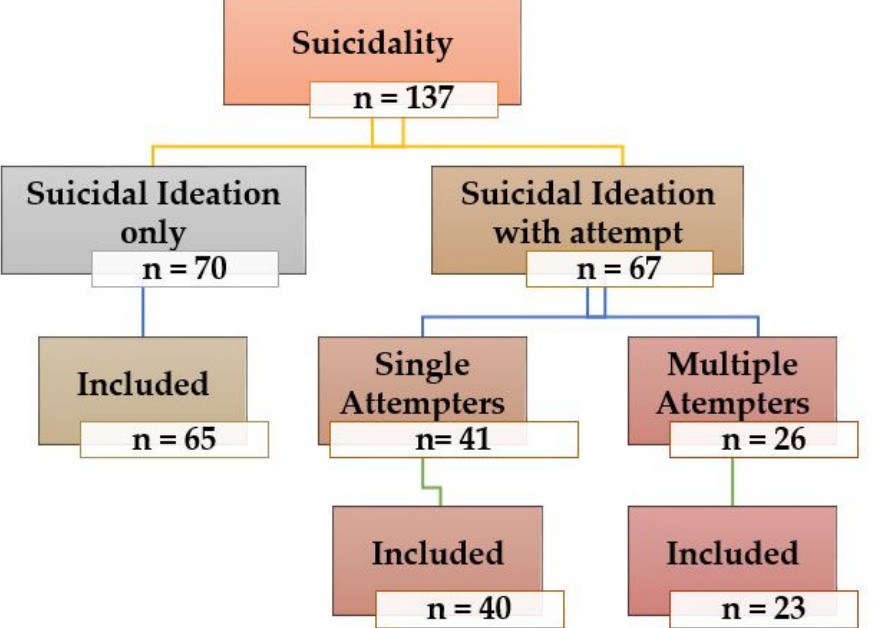
Figure 1. Number and sub classification categories of participants approached for recruitment and included as a study sample for assessment regarding suicidality.